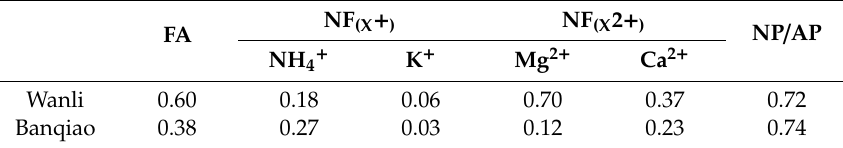
Table 4. Neutralization Factor analysis result.